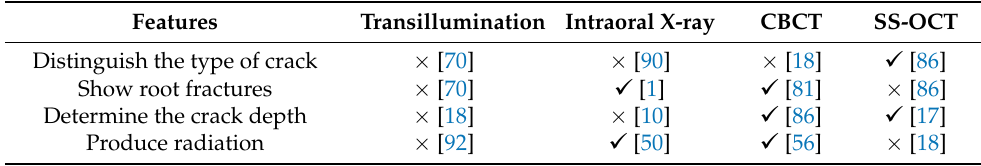
Table 1. Four common methods for identifying cracked teeth [13].